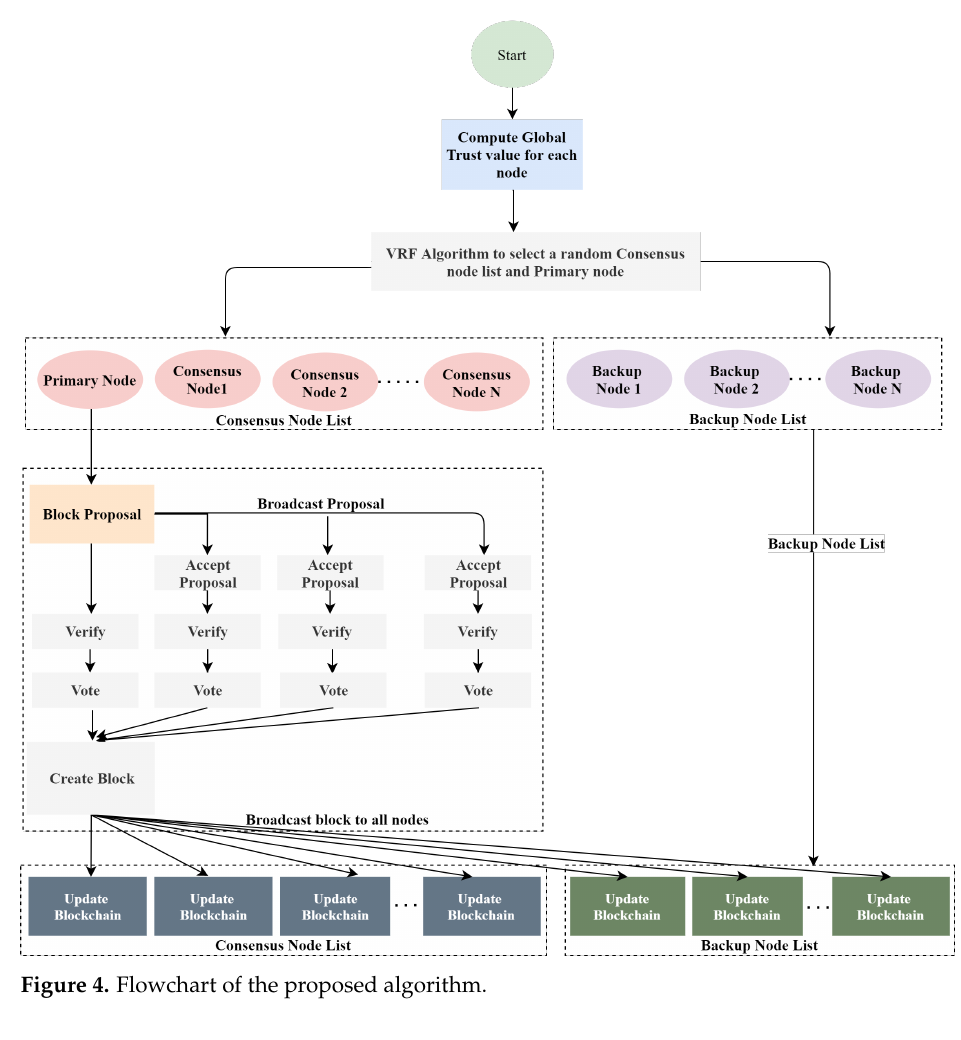
Figure 4. Flowchart of the proposed algorithm.